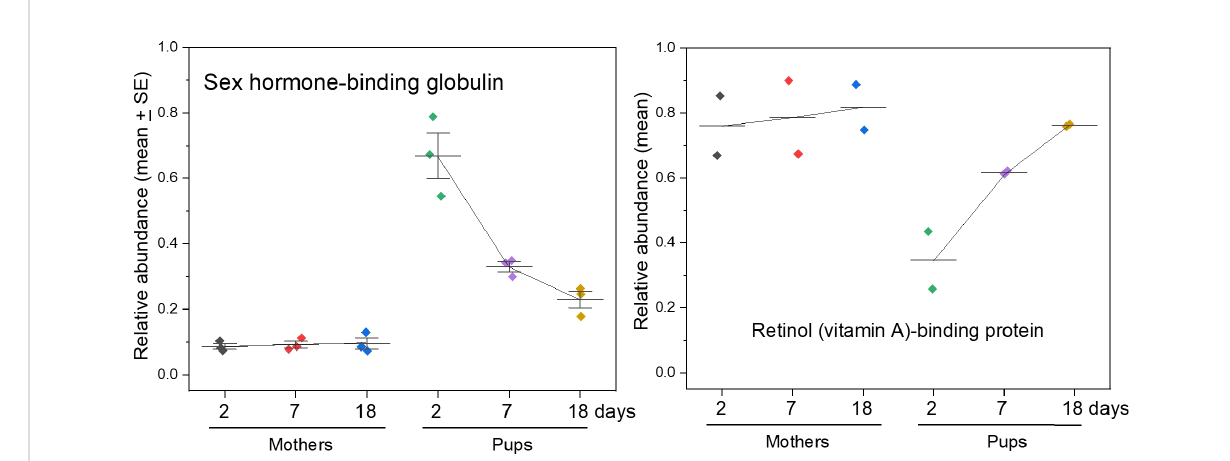
FIGURE 5 Vitamin and hormone-binding proteins. Sex hormone-binding globulin is present at substantially higher levels in pups than in mothers. Retinol (vitamin A)-binding protein (RBP4 isoform) carries retinol in plasma and is found non-covalently associated with transthyretin (which carries the thyroid hormone thyroxine), the resulting complex being large enough to prevent retinol binding protein passing through the kidney fi lter and excreted. See Supplementary Figure S2 for a graph of the relative concentrations of retinol-binding protein and transthyretin showing similar